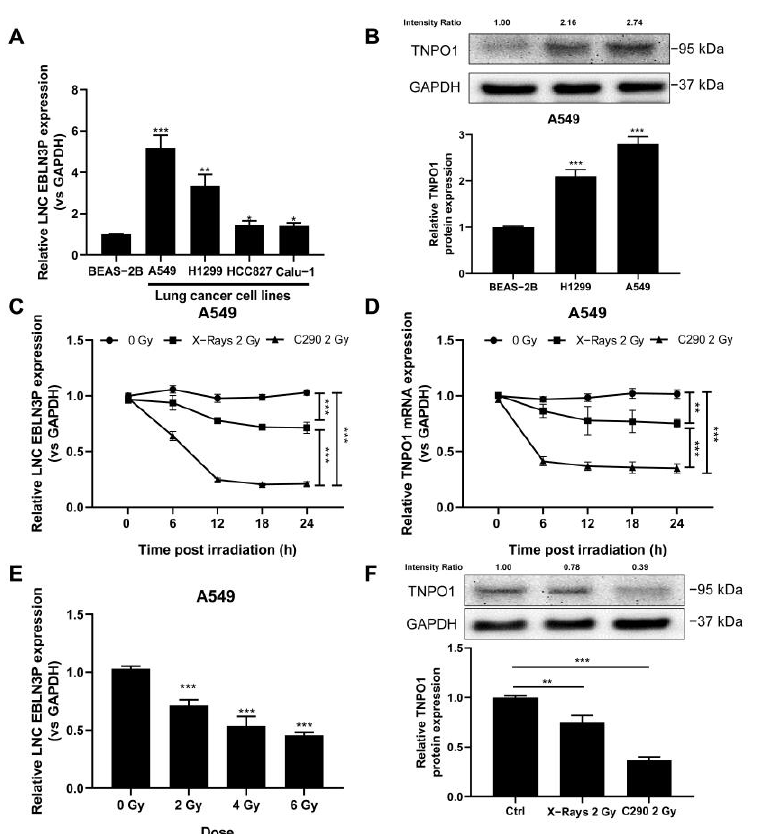
Figure 2. X − ray and carbon ion irradiation induced differential downregulation of LNC EBLN3P in lung cancer cells. ( A ) The basic expression levels of LNC EBLN3P in BEAS − 2B and NSCLC cells (A549, H1299, HCC827 and Calu − 1) were tested by qRT − PCR. ( B ) The TNPO1 protein levels of cells were tested by western blotting. ( C , D ) The mRNA levels of LNC EBLN3P and TNPO1 are both down − regulated over time in A549 cells irradiated with X − rays or carbon ions. ( E ) Expression of LNC EBLN3P was tested in A549 cells which suffered different doses of X − ray irradiation (samples were collected 24 h after irradiation). ( F ) TNPO1 protein levels were determined with western blotting in A549 cells exposed to the same dose of X − rays and carbon ions. Data shown in A–E represent the mean ± SD ( n = 3). * p < 0.05, ** p < 0.01, *** p < 0.001.